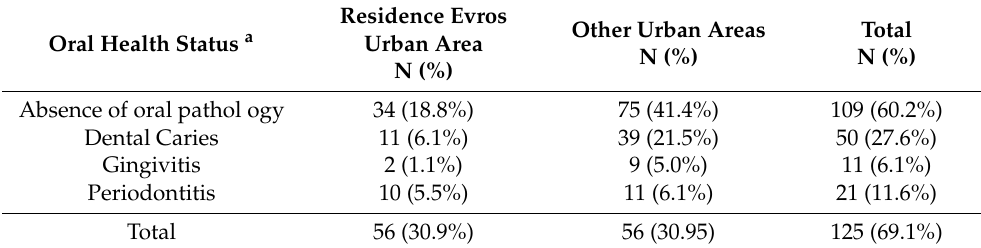
Table 5. Place of residence of children (Evros/other areas) in relation to the condition of oral